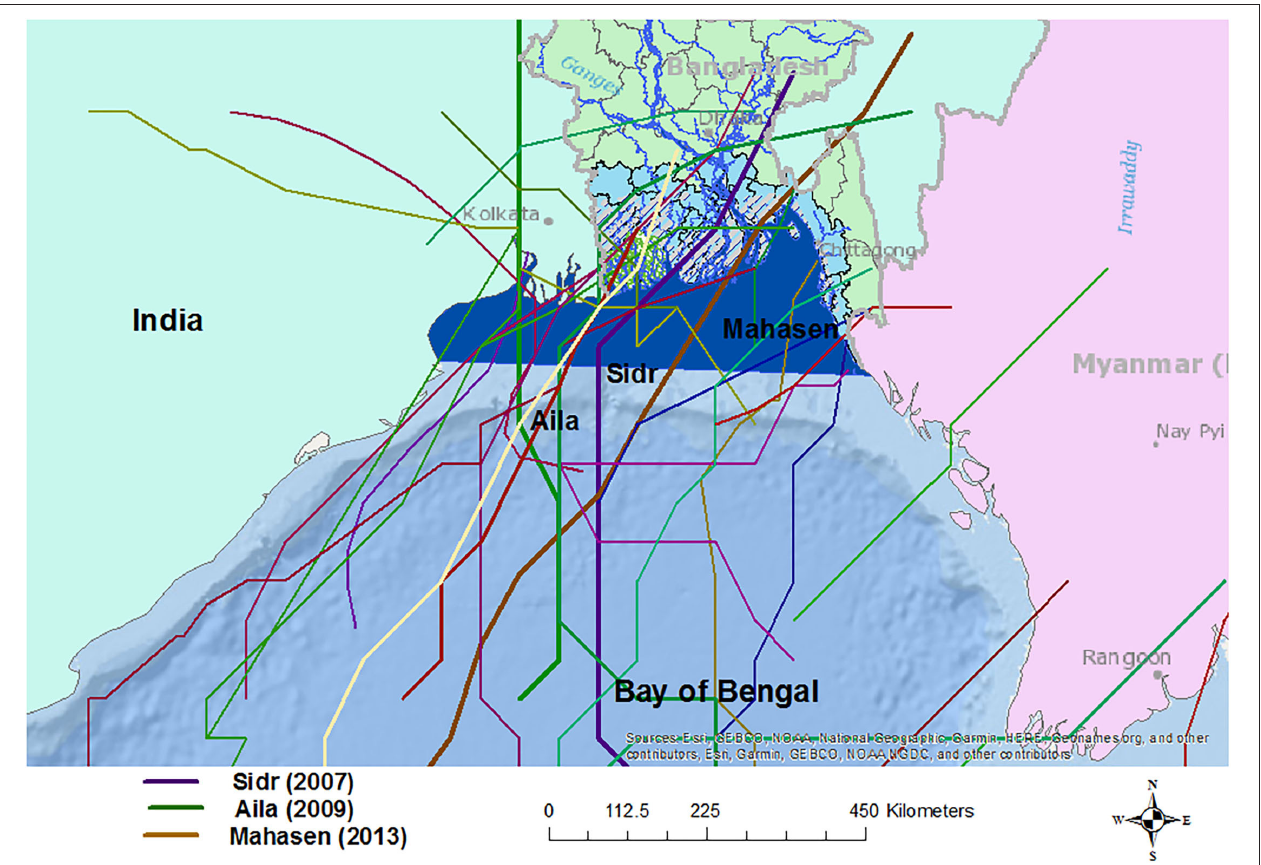
FIGURE 9 | Track and landfall locations of the simulated cyclones in the coastal regions of Bangladesh and in the Bay of Bengal (Sidr, Aila, and Mahasen tracks are